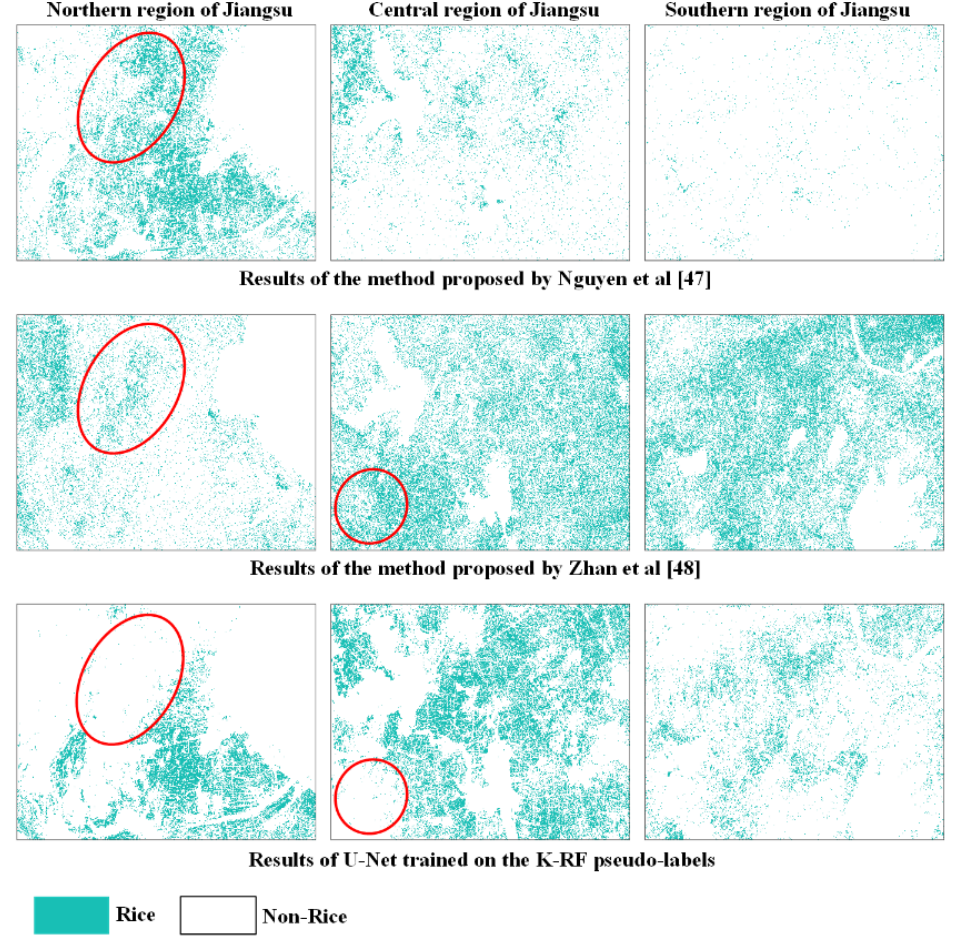
Figure 11. Extraction results in the different parts of the target region based on different methods. The first row to third row represent the rice extraction results using the method based on Nguyen et al. [47], and Zhan et al. [48], and the U-Net model trained on the K–RF pseudo-labels, respectively. The first to third columns represent the rice extraction results in the northern, central and southern parts of the target region, respectively.